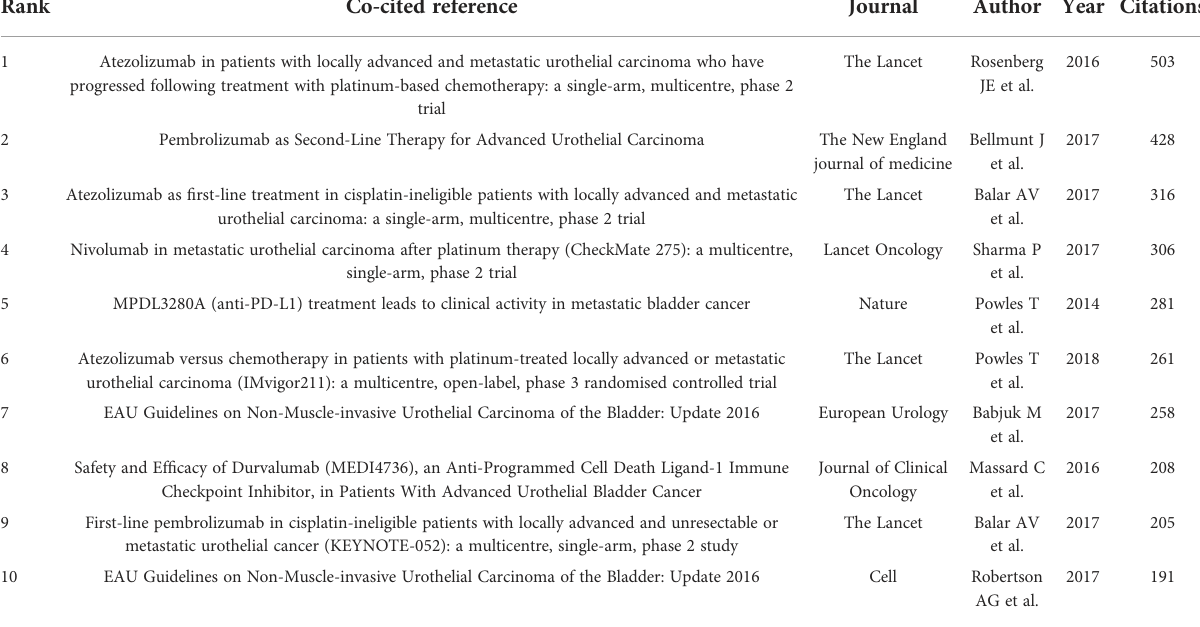
TABLE 5 The Top 10 co-cited references in BC immunotherapy